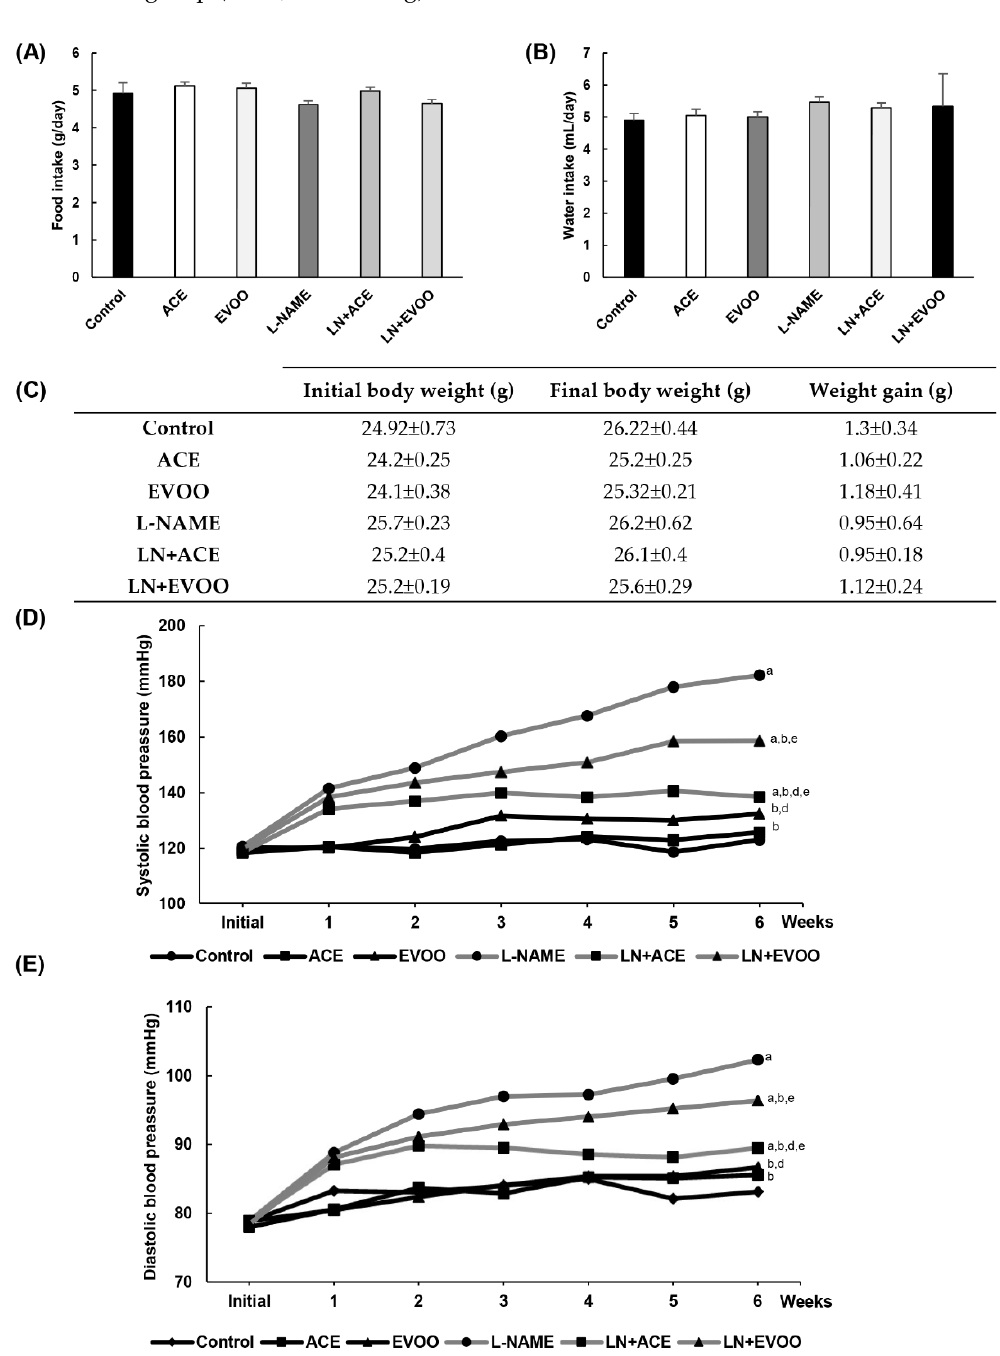
Figure 1. Animal general characteristics. ( A ) Food intake, ( B ) water intake and ( C ) weight gain in experimental animal groups. The weekly progression of ( D ) systolic blood pressure (SBP) and ( E ) diastolic blood pressure (DBP) are represented for each animal group. Values are expressed as mean ± SEM of seven animals per group: a p < 0.05 vs. control; b p < 0.05 vs. NG-nitro-L-arginine-methyl-ester (L-NAME); d p < 0.05 vs. L-NAME-induced hypertensive mice supplemented with 12% of EVOO (LN + EVOO); e p < 0.05 vs. ACE.